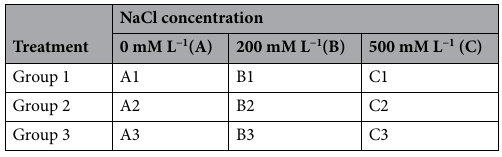
Table 3. Experimental